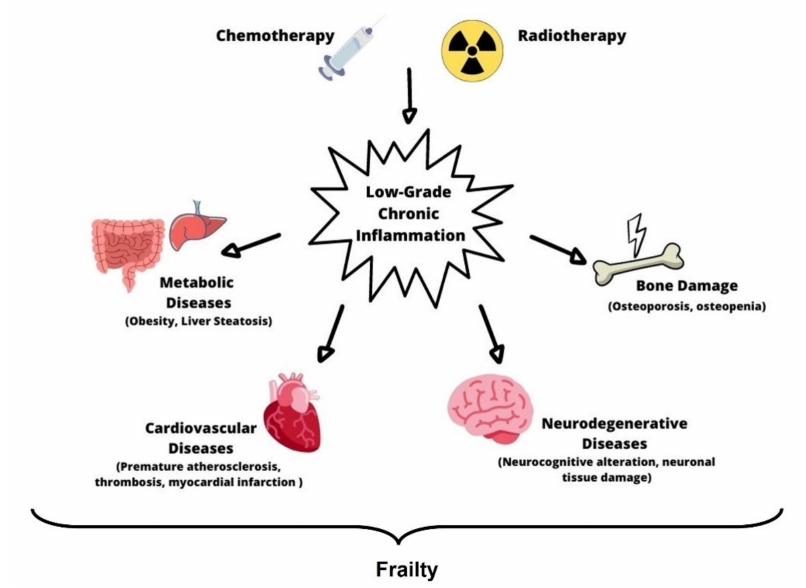
Figure 1. Frailty. Chemotherapy and radiotherapy cause a low-grade chronic inflammation in childhood cancer survivors, which is responsible for premature ageing processes and vital organ failure. This condition, known as frailty, determines the onset of several pathological conditions, such as metabolic diseases, cardiovascular diseases, neurodegenerative diseases, and